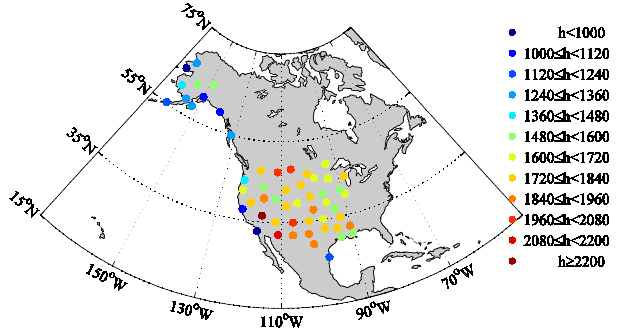
Figure 7. Pattern of climatological h con over North America during the period 1998–2008 (unit: m). The 57 stations shown here are the stations which meet the long-term average criteria mentioned at the beginning of Sect 3.1.